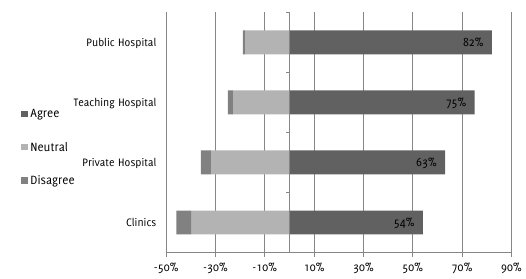
Figure 3. Patients’ Agreement on whether White Coats should be Worn in Various Clinical Settings